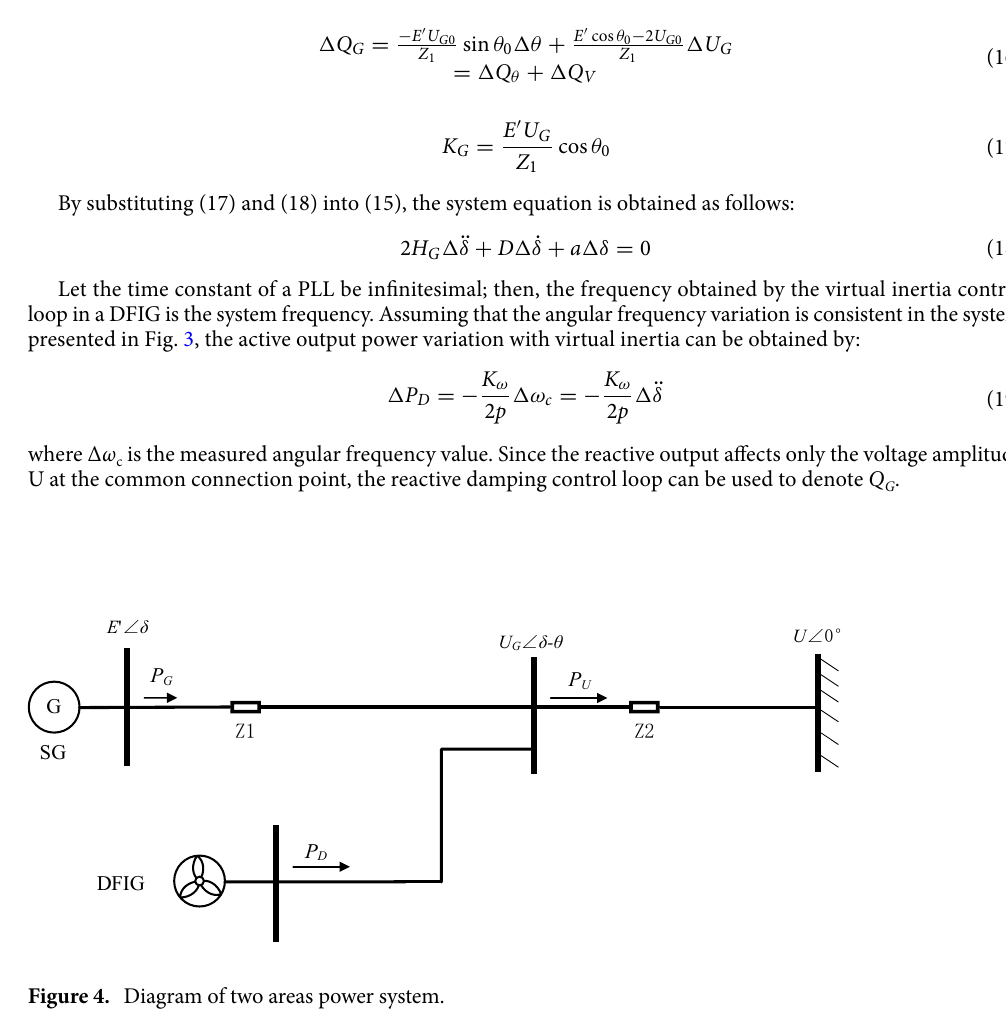
Figure 4. Diagram of two areas power